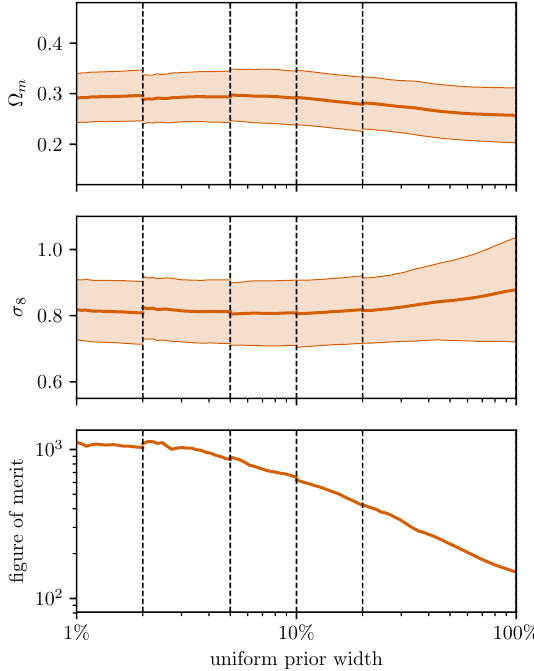
Figure 9. Mean and standard deviation of the marginal posterior distribution for Ω m and σ 8 as functions of the relative width of uniform priors on the efficiency parameters. The figure of merit quantifies the constraining power of the joint distribution. Dashed lines indicate a change in the underlying